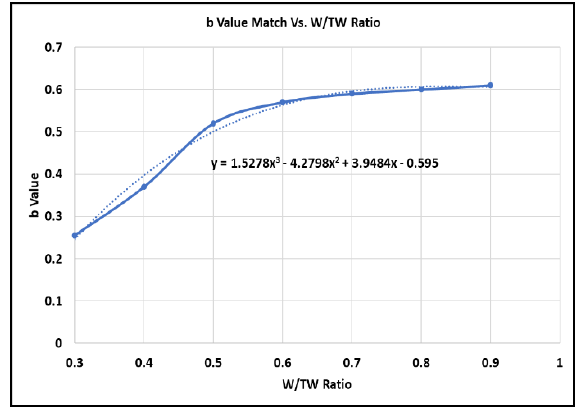
Figure A7. Correlation of b-value match for secondary hyperbolic decline with corresponding well spacing